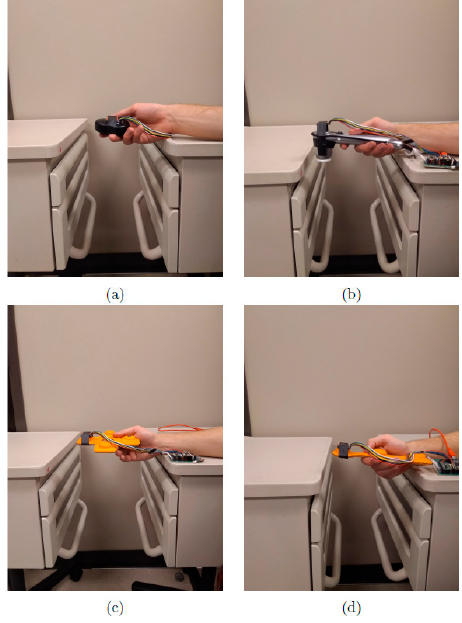
Figure 2. Test setup for free vibration. The vibration device was held lightly in the hand. ( a ) Vibracool, ( b ) Novafon Pro, ( c ) Myovolt three-actuator, and ( d ) Myovolt two-actuator.